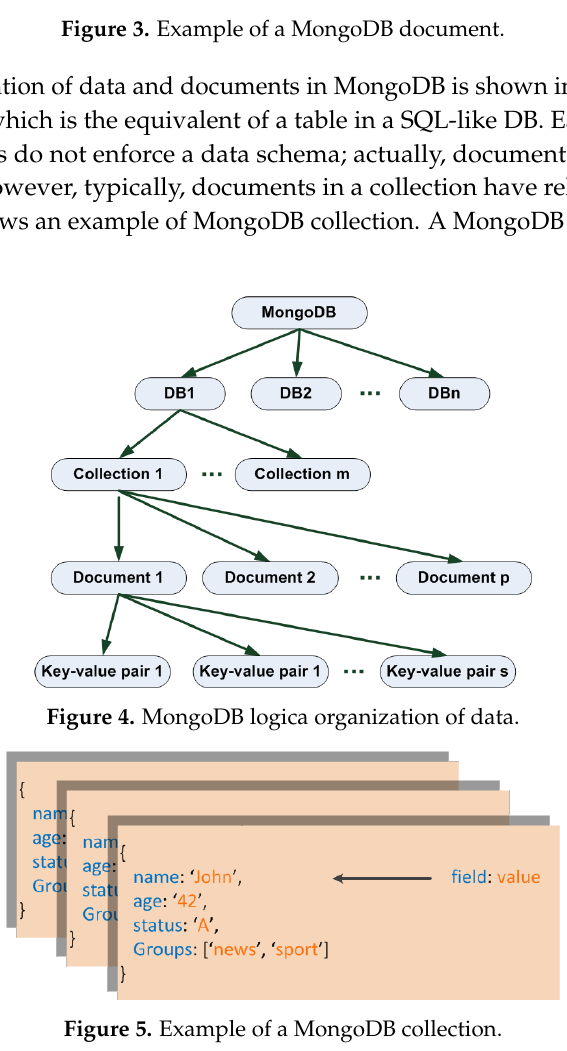
Figure 5. Example of a MongoDB